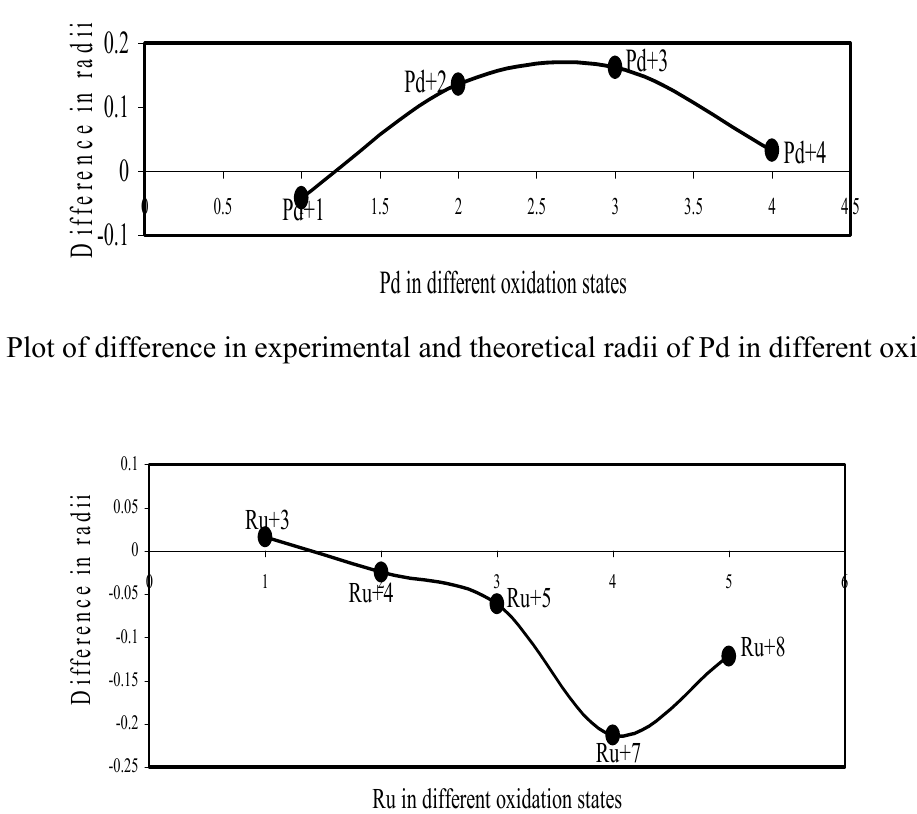
Figure 19. Plot of difference in experimental and theoretical radii of Mo in different oxidation states.